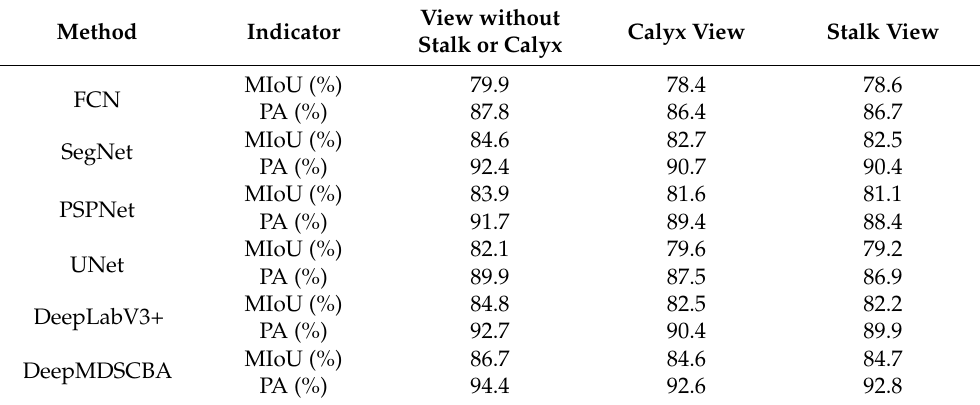
Table 9. Segmentation performance of apple images with different rot